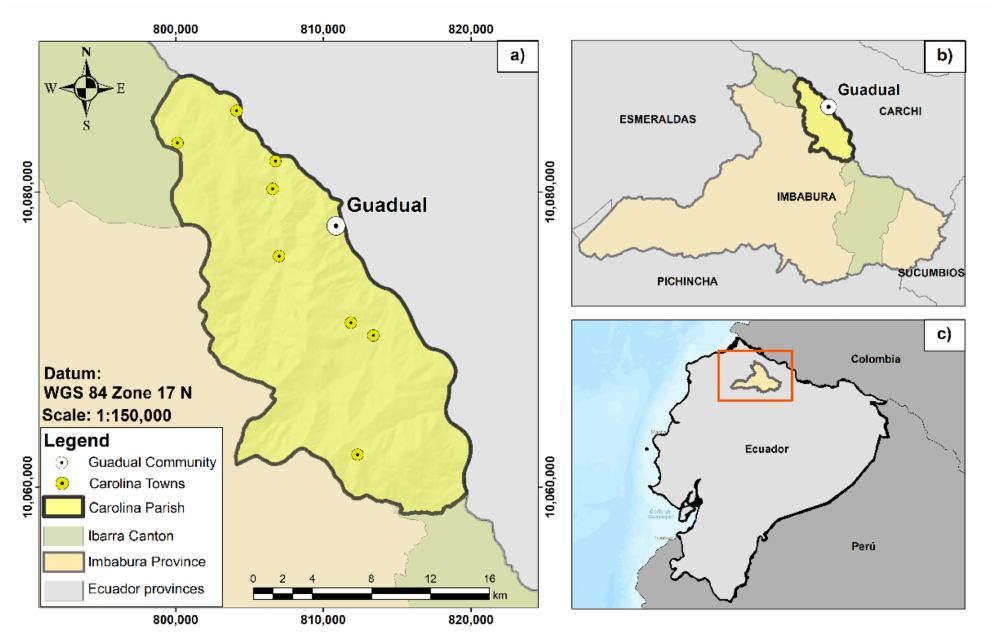
Figure 1. Study area location: ( a ) La Carolina parish, ( b ) Ibarra canton and ( c ) macro-location in Ecuador.